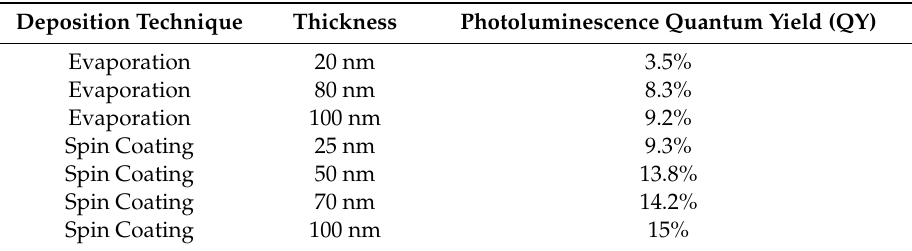
Table 1. QY of the deposited layers as a function of layer thicknesses.